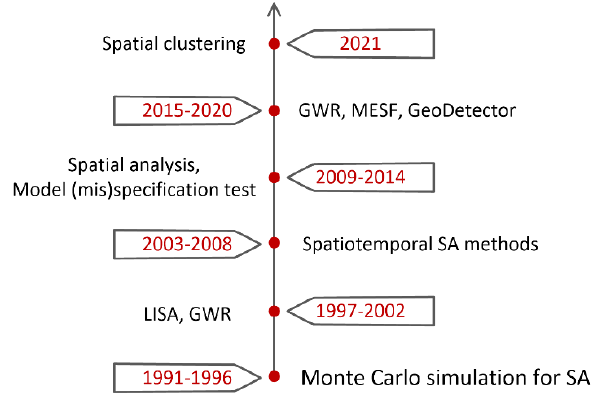
Figure 12. Development of SA research in geographical domains 1991 –